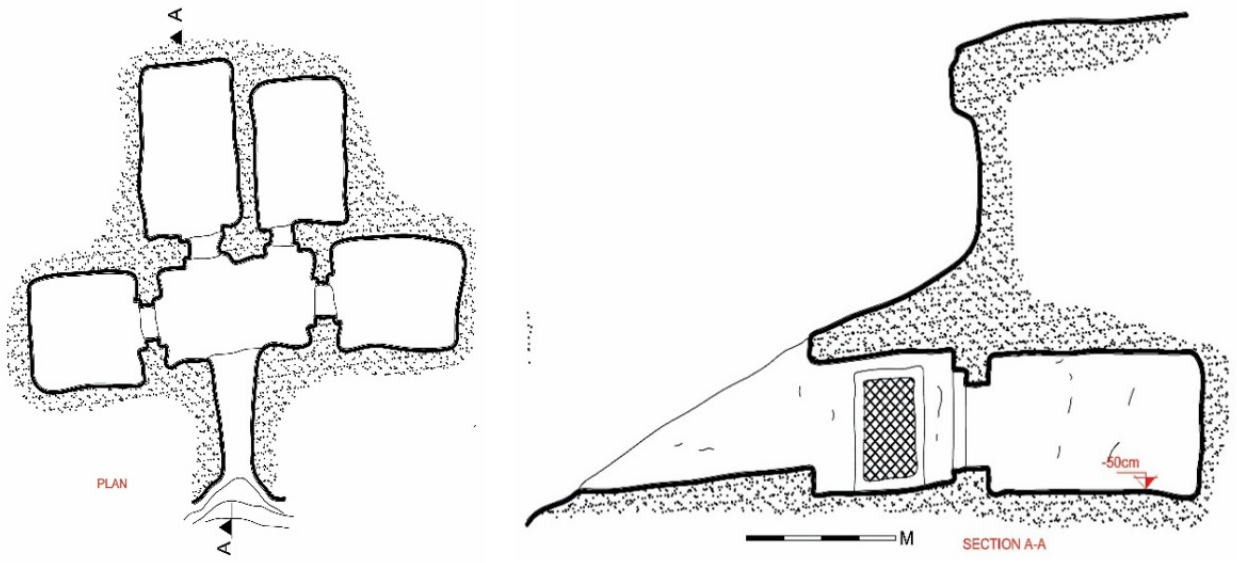
Figure 22. The fourth-stage fulfillment of excavation of rooms in cross − section and plan view.